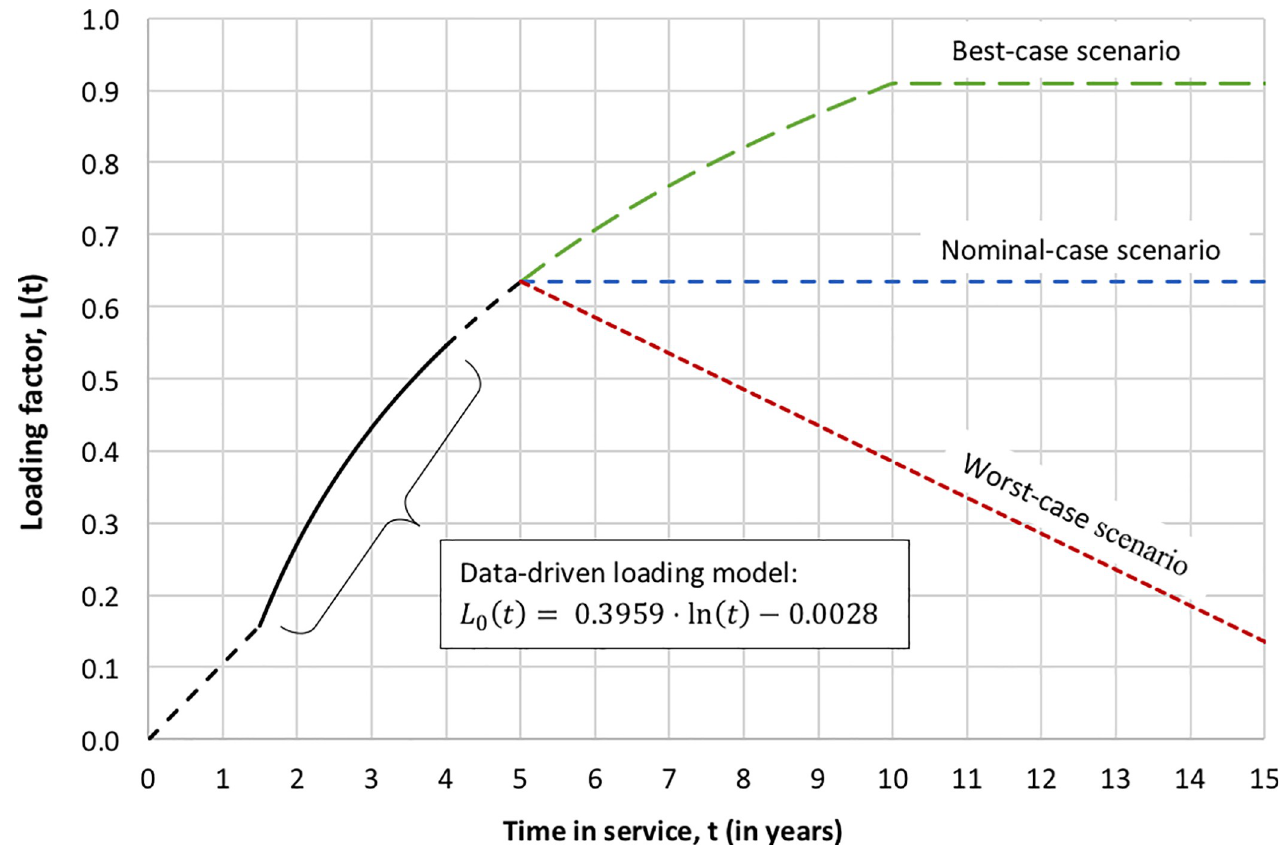
Fig 7. HTS loading profiles as a function of time with best-case, nominal-case, and worst-case scenarios.